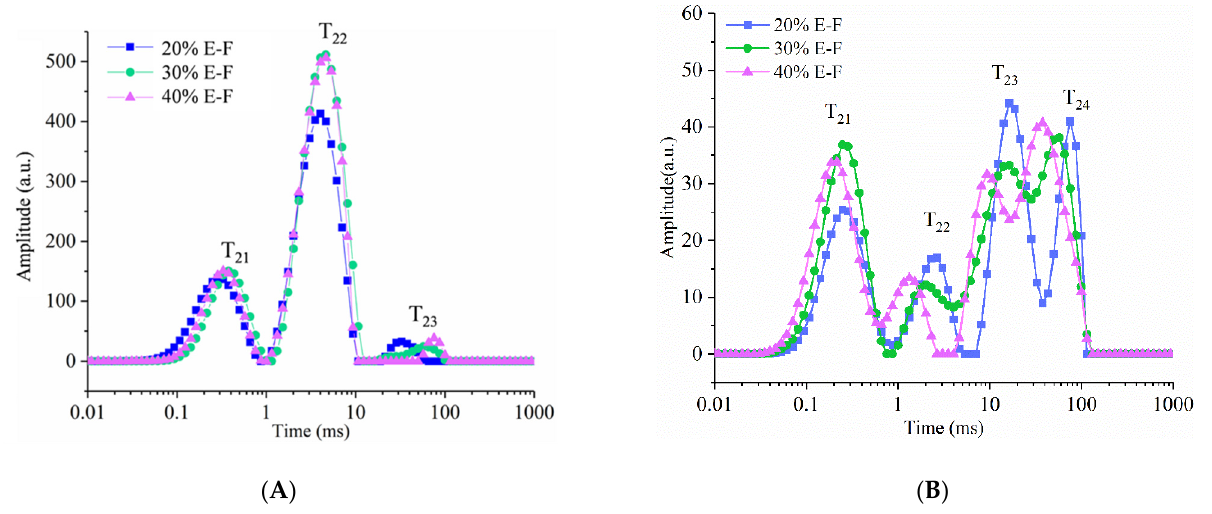
Figure 5. Water distribution curves of fresh noodles ( A ) and cooked noodles ( B ). The 20% E-F, 30% E-F, and 40% E-F represent that the addition of extruded starch in the noodles was 20%, 30%, and 40%,